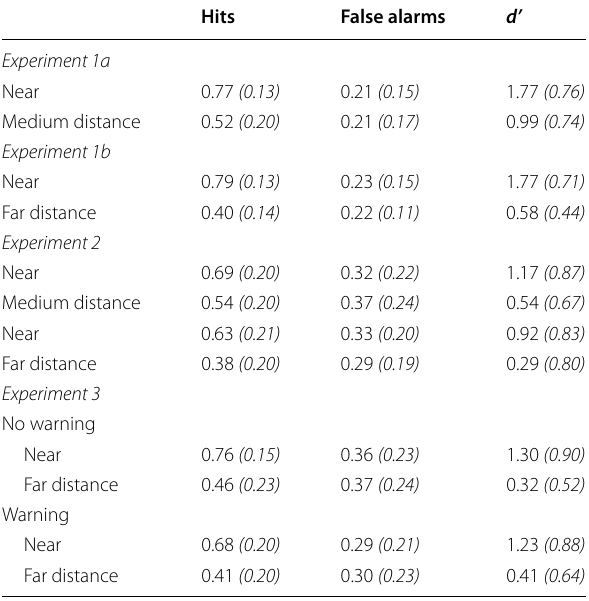
Table 1 Hits, false alarms, and d’ values for each condition